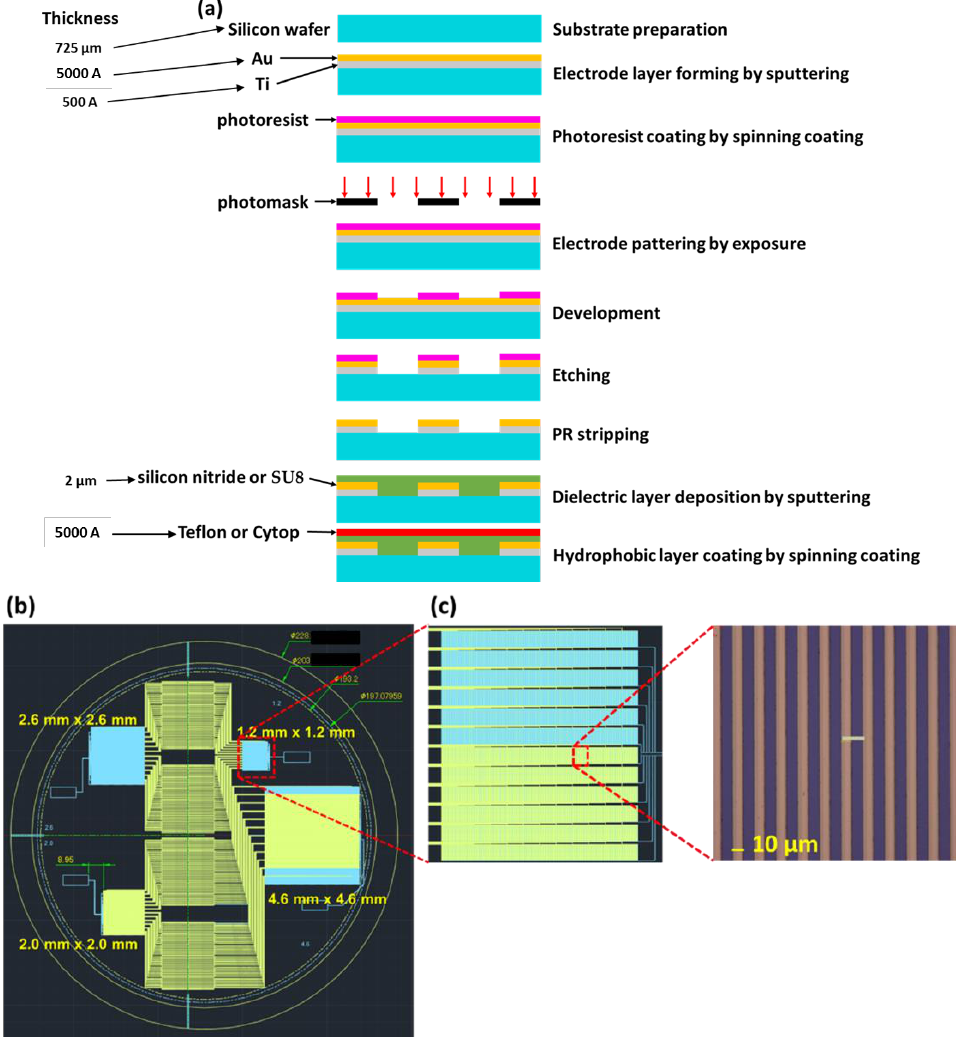
Figure 4. ( a ) Manufacture process flow of dielectric chip. ( b ) Design of the dielectric chip. ( c ) Design of the interdigital electrode.